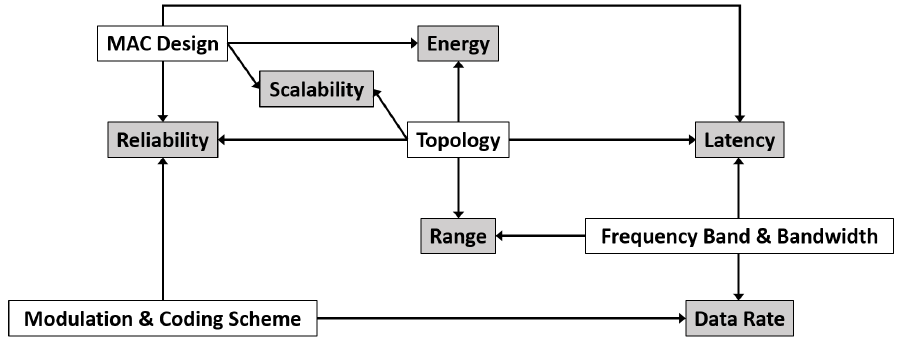
Figure 4. Network design choices (white rectangles) influence several performance properties simultaneously (grey rectangles), thus creating the trade-offs between